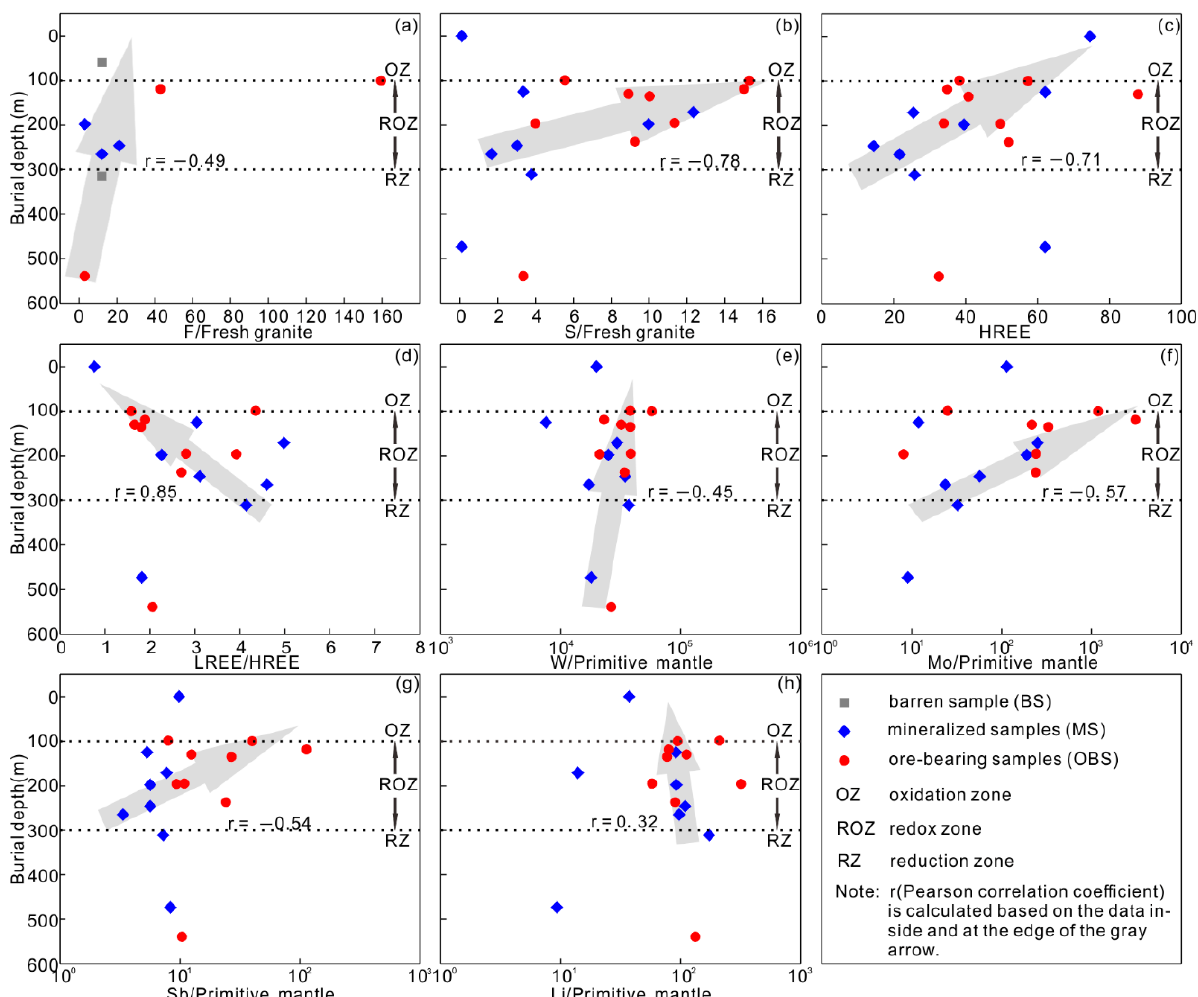
Figure 7. Scatter plots of some elements and element combinations in various altered granites versus burial depth (Bd). ( a ) F vs. Bd, ( b ) S vs. Bd, ( c ) HREE vs. Bd, ( d ) LREE/HREE vs. Bd, ( e ) W vs. Bd, ( f ) Mo vs. Bd, ( g ) Sb vs. Bd, ( h ) Li vs. Bd.